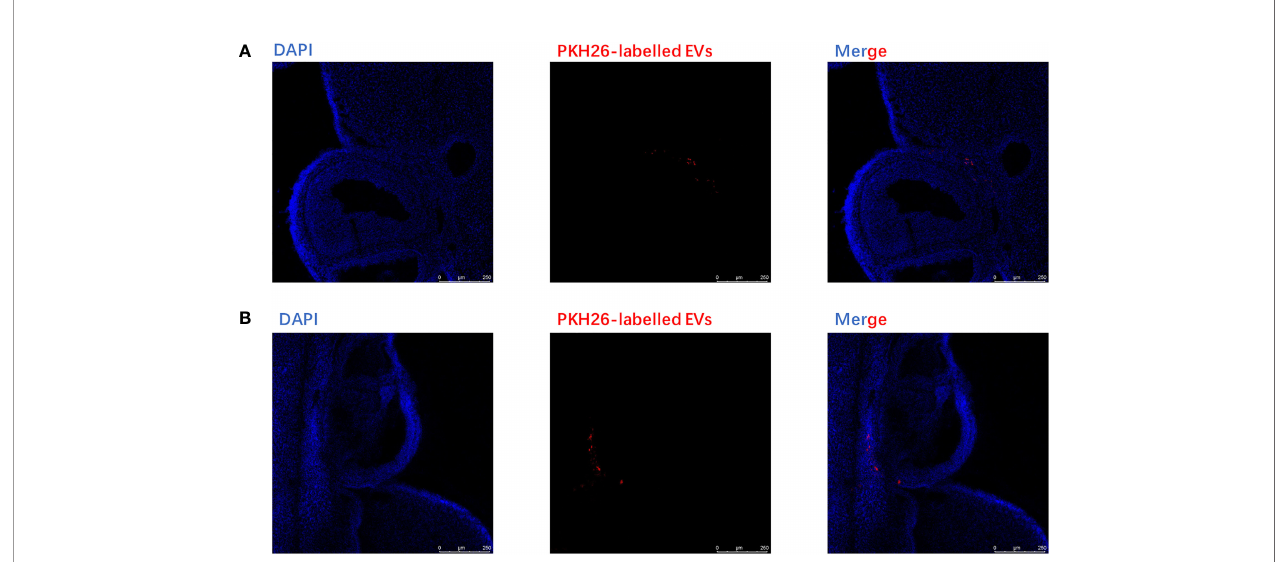
FIGURE 5 | Extracellular vesicles derived from adipocytes were internalized by ovaries. (A) The analysis of extracellular vesicles derived from adipocytes in ovary was conducted by confocal microscopy after injecting the EVs intravenously in mice for 6 h. The PKH26-labeled EVs derived from adipocytes (red);, the nuclei of the CC cells were stained with DAPI (blue). (B) The analysis of extracellular vesicles derived from adipocytes in the ovary was conducted by confocal microscopy after injecting the EVs intravenously in mice for12 h. The PKH26-labeled EVs derived from adipocytes (red); the nuclei of the CC cells were stained with DAPI (blue).